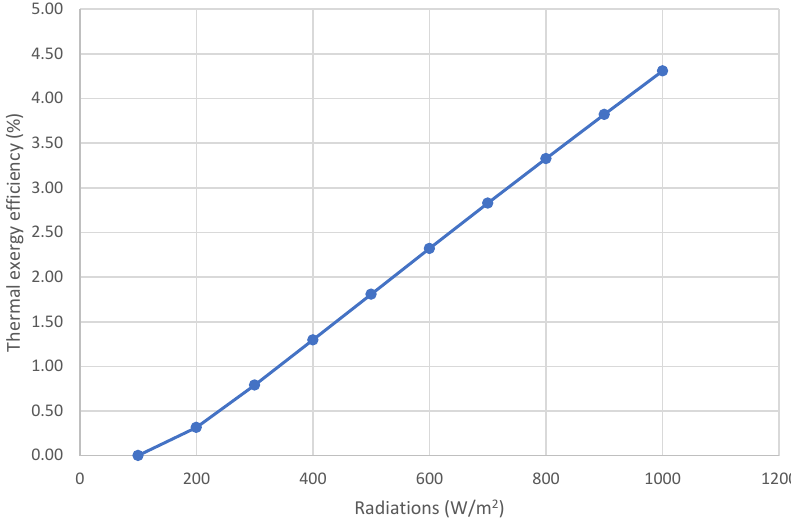
Figure 7. Exergy efficiency response of FPC.